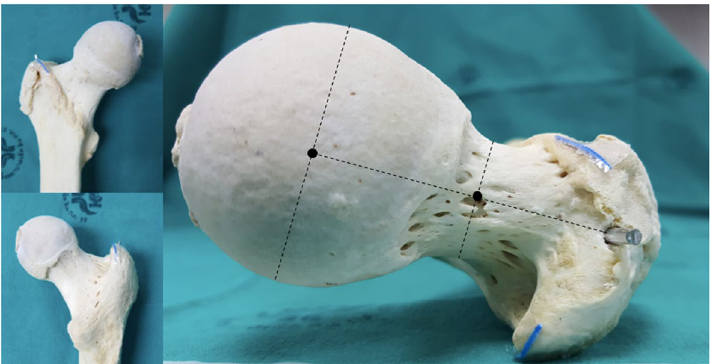
Figure 1. Marking the anatomical landmarks. A wire was inserted into the tip of greater trochanter, which was defined as the intersection between the line connecting the centre of the femoral head with the centre of the femoral neck on axial view and the most proximal aspect along the greater trochanteric crest on the anteroposterior view. The blue lines are markers attached to the antero- and postero-superior borders of the greater